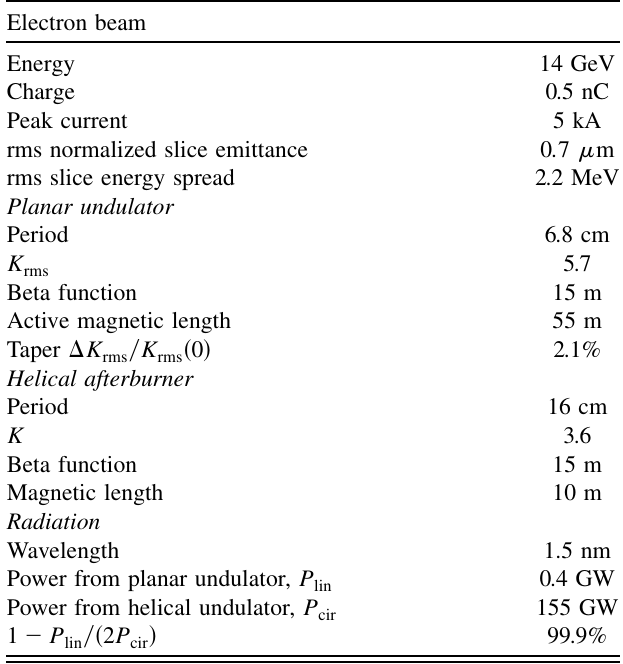
TABLE I. Main parameters used in simulations.